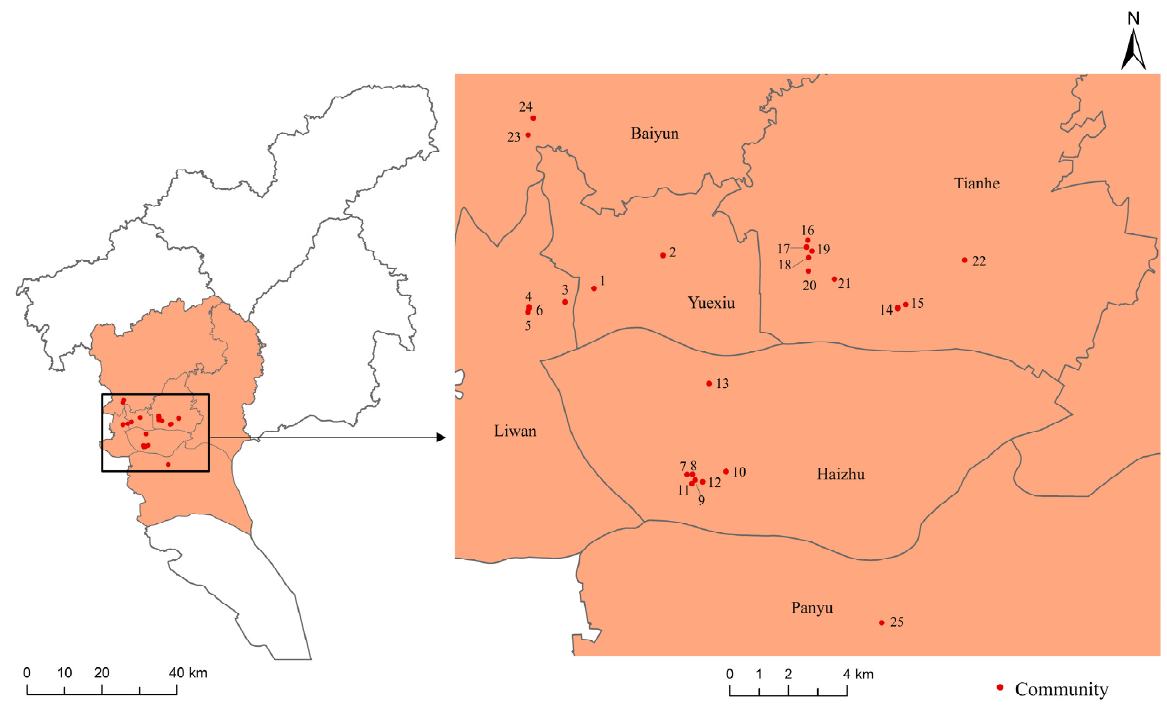
Figure 2. Study area and 25 sampled communities.